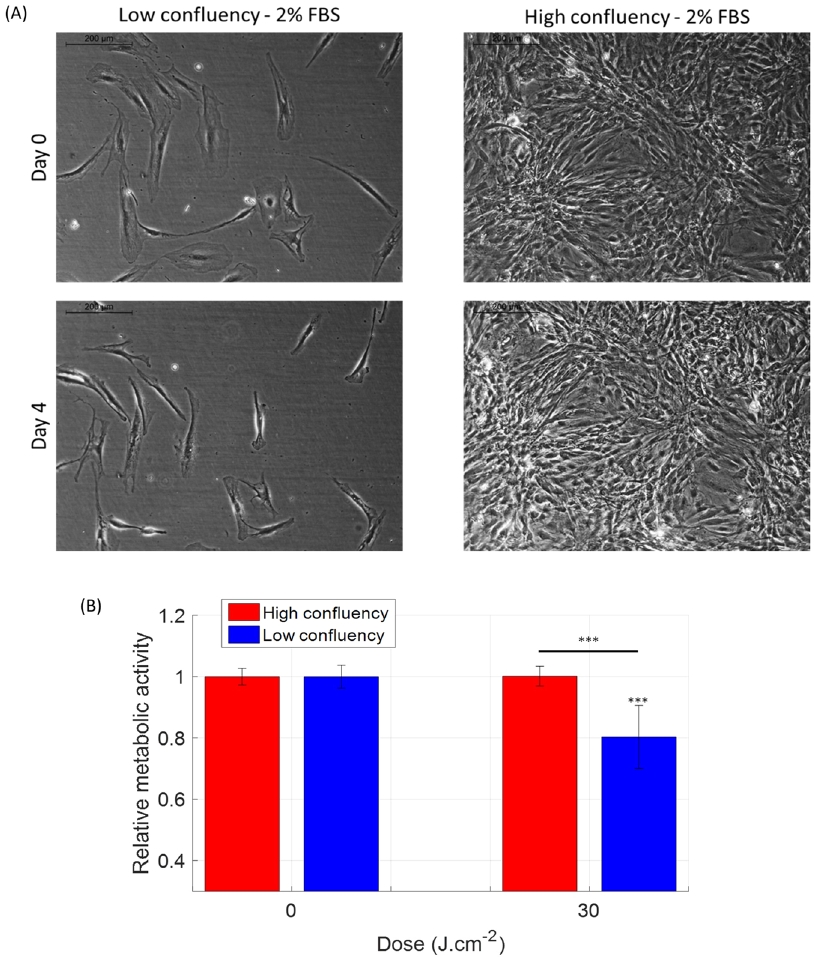
Figure 4. An increase in the cell confluency of human dermal fibroblasts reduces the inhibitory effect of blue light (450 nm) on their metabolic activity. ( A ) Phase-contrast images of human papillary fibroblasts on day 0 (8 days after seeding) at a low initial confluency (upper left) and high initial confluency (upper right), and after three light treatments on day 4 at a low initial confluency (lower left) and high initial confluency (lower right). Reticular fibroblasts were found to behave similarly (not shown). ( B ) Relative metabolic activity of human papillary fibroblasts after light treatment at 450 nm, 50 mW.cm − 2 with 30 J.cm − 2 in function of the confluency level. Statistical analysis was evaluated using student t-tests between the control group and the treated group (N = 3, 2 lineages and 3 replicates), with following thresholds * p < 0.05, ** p < 0.01, *** p < 0.001. The control group has an average relative metabolic activity of 1. The significance of the interaction between the radiant exposure and the confluency level was much lower than